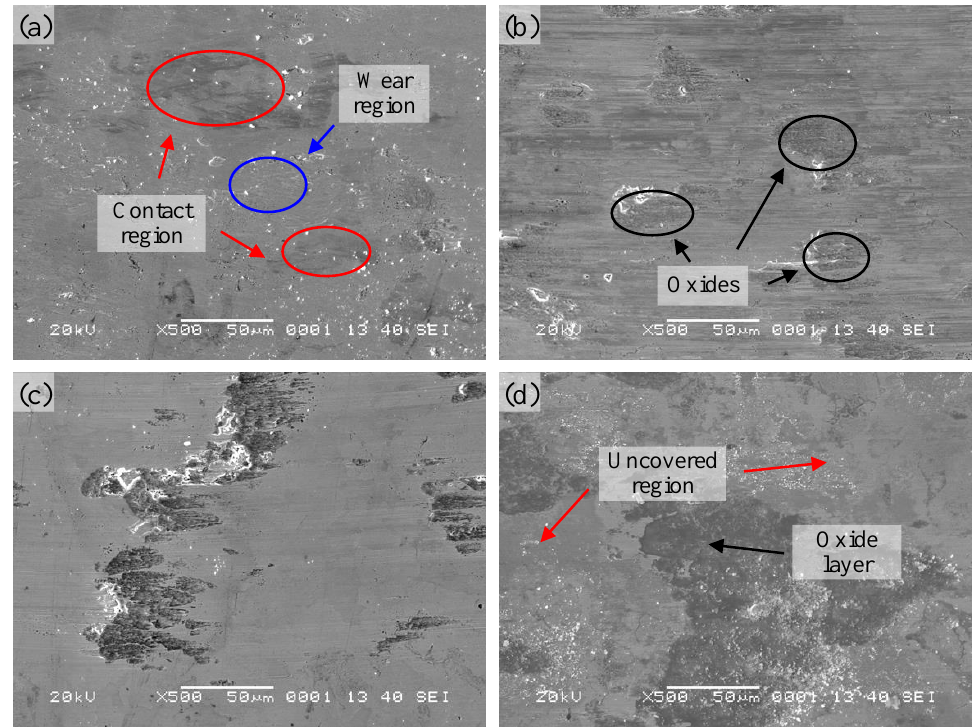
Figure 5. SEM micrographs of worn surface of Ni 3 Si alloy with 5% Ti addition at different temperatures: ( a ) 25; ( b ) 200; ( c ) 400; ( d ) 600 °C.